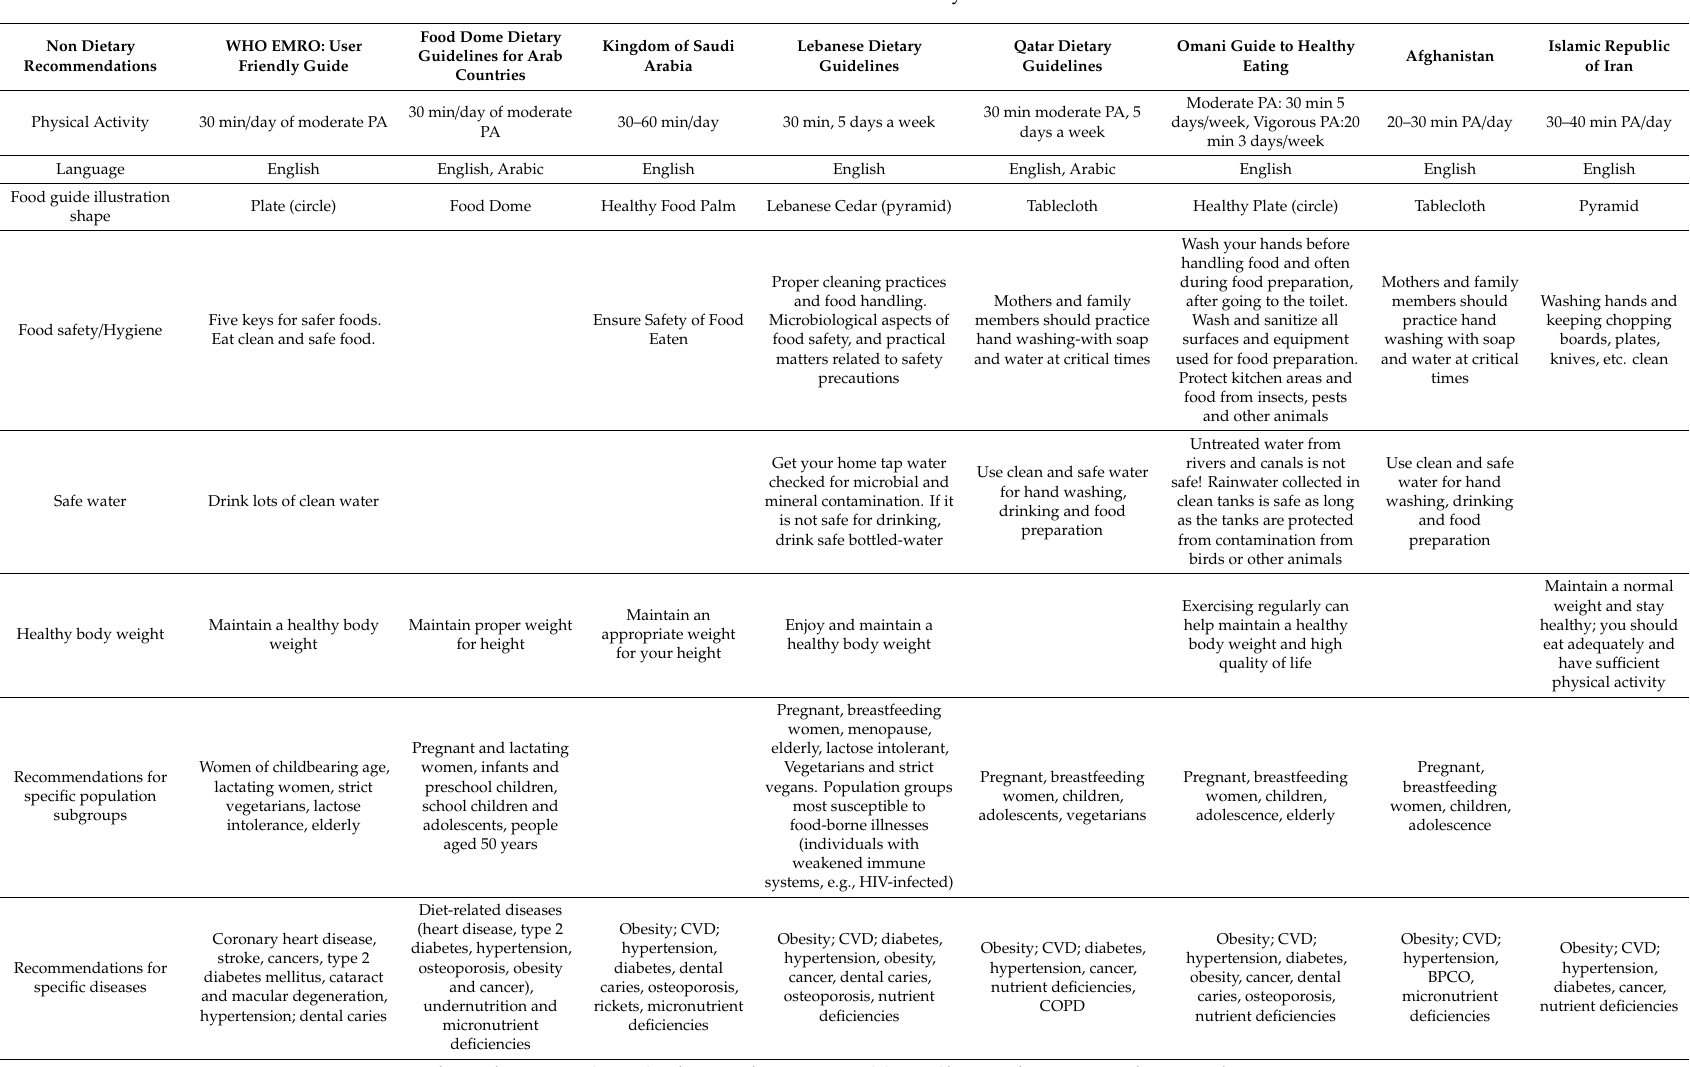
PA: Physical Activity; CVD: Cardiovascular Diseases; COPD: Chronic obstructive pulmonary